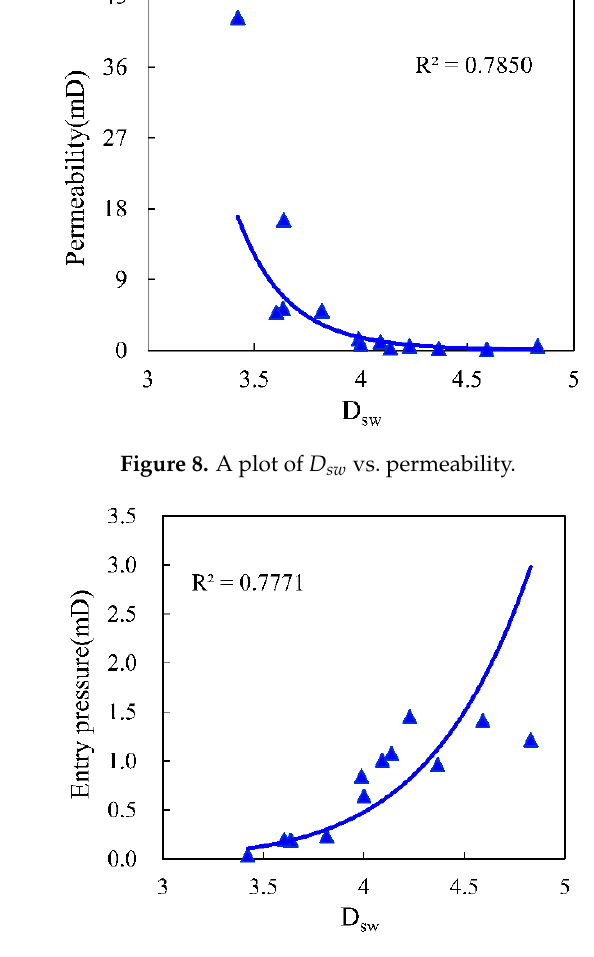
Figure 9. A plot of D sw vs. entry pressure.